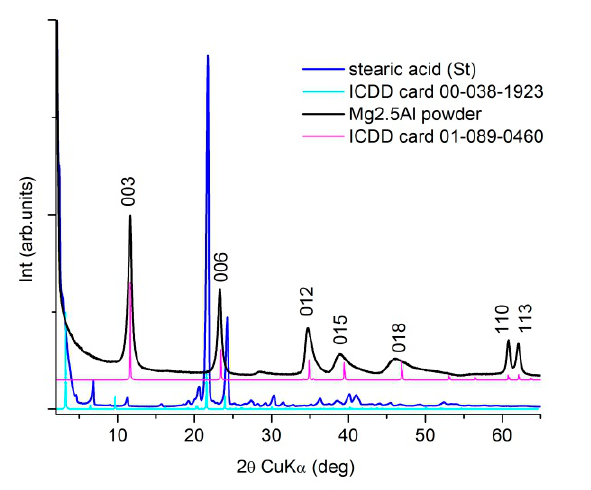
Figure 2. XRD patterns of the primary materials used for the targets’ preparation.